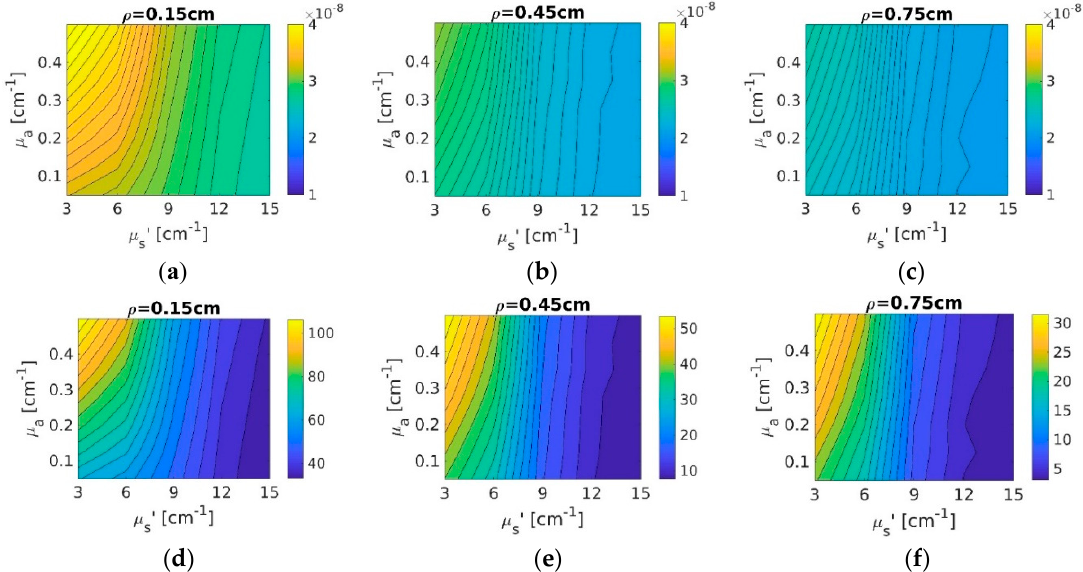
Figure 4. Retrieved flow coe ffi cients obtained via using Equation (2) to fit simulations (top-row) and corresponding percent-errors (bottom-row) for 35 di ff erent MC simulations spanning seven µ a and five µ (cid:48) s values and fixed D B = 2 × 10 − 8 cm 2 / s. Data are shown as contour maps for 3 di ff erent SDS (left column: SDS = 0.15 cm; middle column: SDS = 0.45 cm; right column: SDS = 0.75 cm). Note that the color-bar scale is fixed for the top row but changes across SDS for the bottom row.